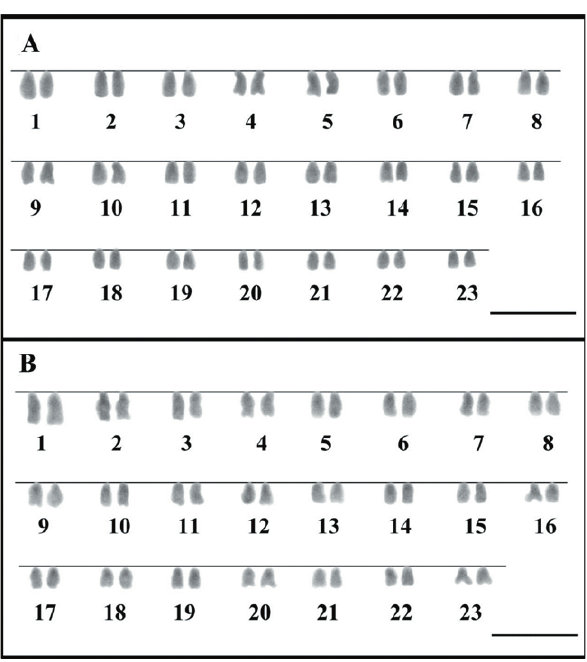
Figure 2. Karyotypes of male (A) and female (B) of Trichopodus microlepis , 2 n =46 by conventional staining. Scale bars = 5 µm.